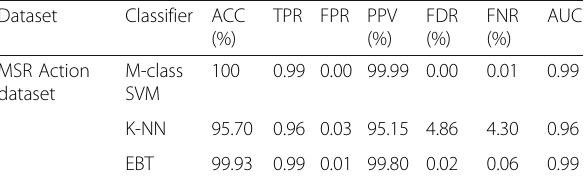
Table 4 Average results of proposed algorithm using MSR Action dataset Dataset